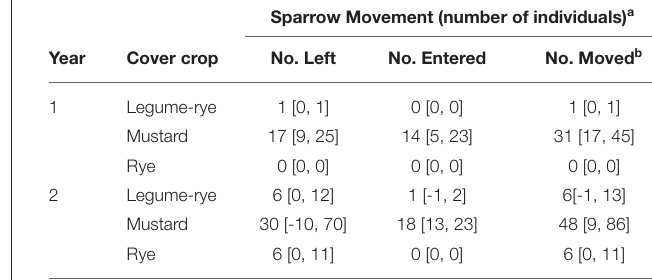
TABLE 3 | Sparrow movement between cover crop plots at 1,045–1,400h in Salinas, CA USA on 3 days each year at the end (Feb and Mar) of the cover cropping